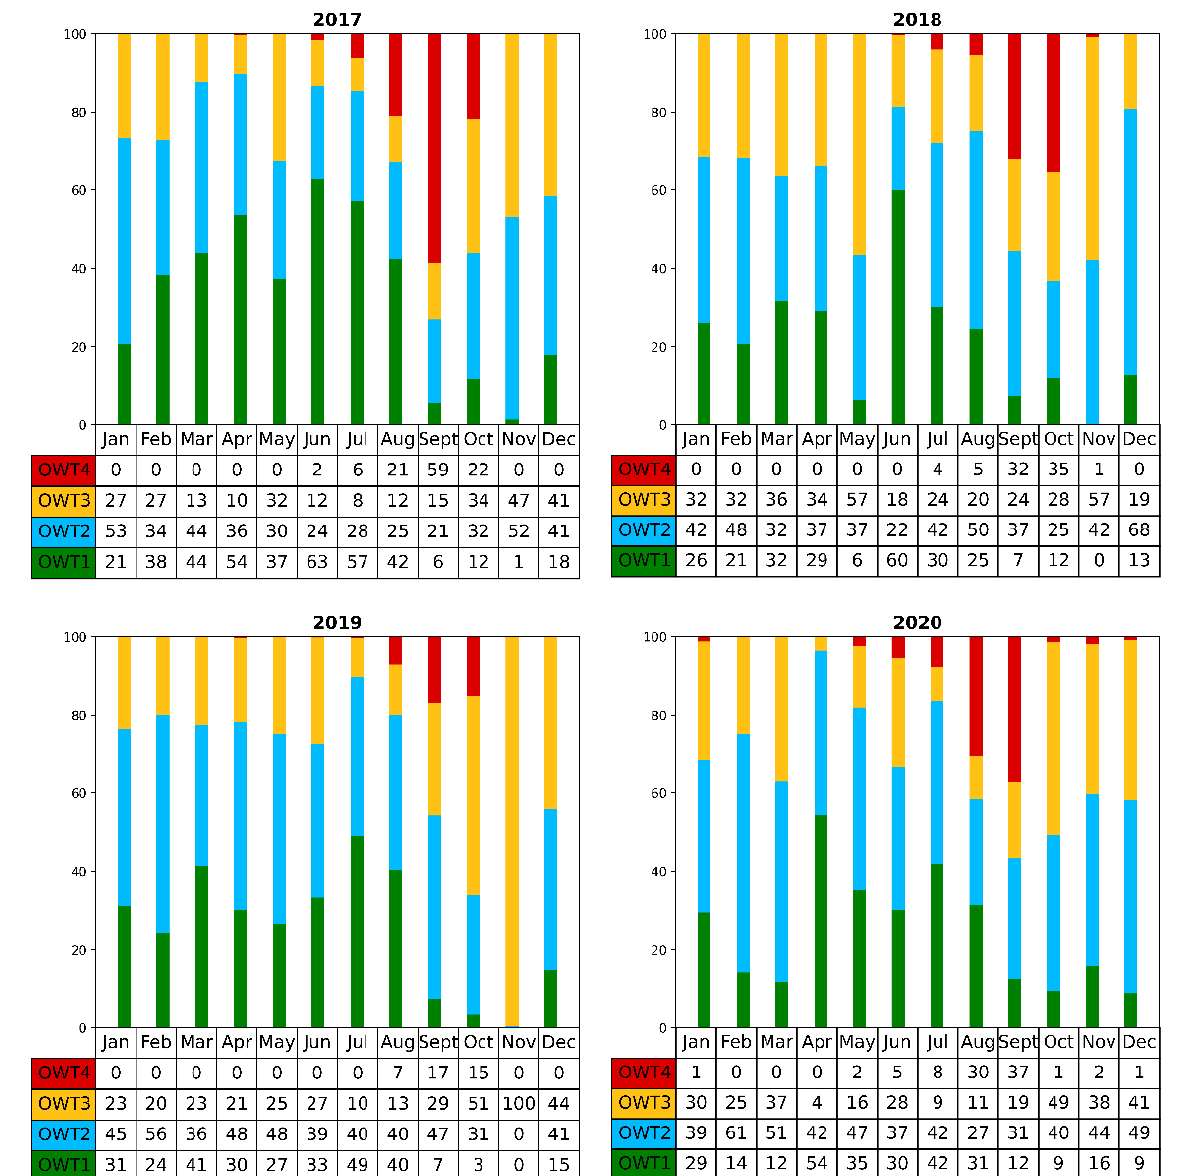
Figure 9. Frequency of the four OWTs by year and by month.